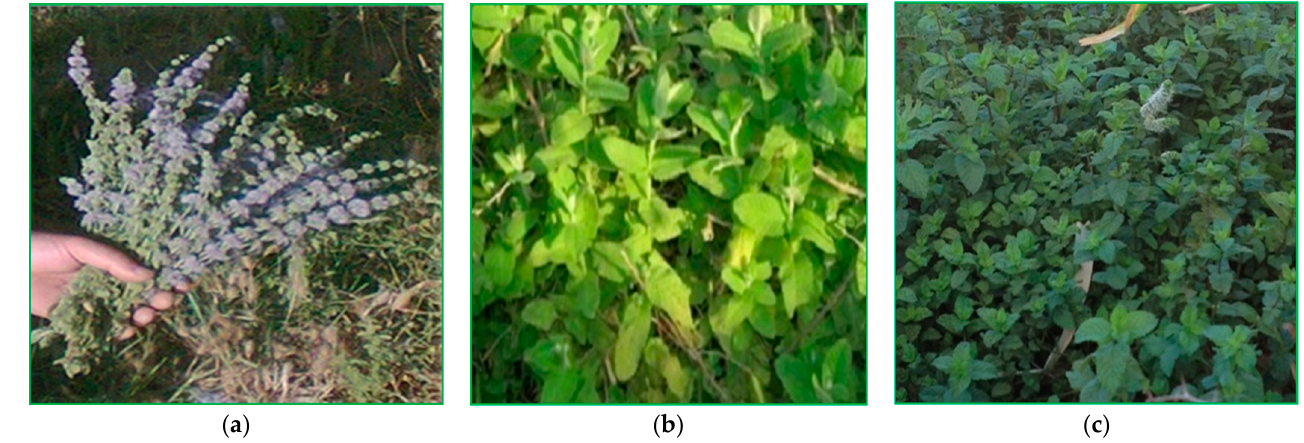
Figure 1. Morphological aspect of three selected Mentha species: ( a ) M. pulegium (L.), ( b ) M. suaveolens (Ehrh.) and ( c ) M. spicata (L.).